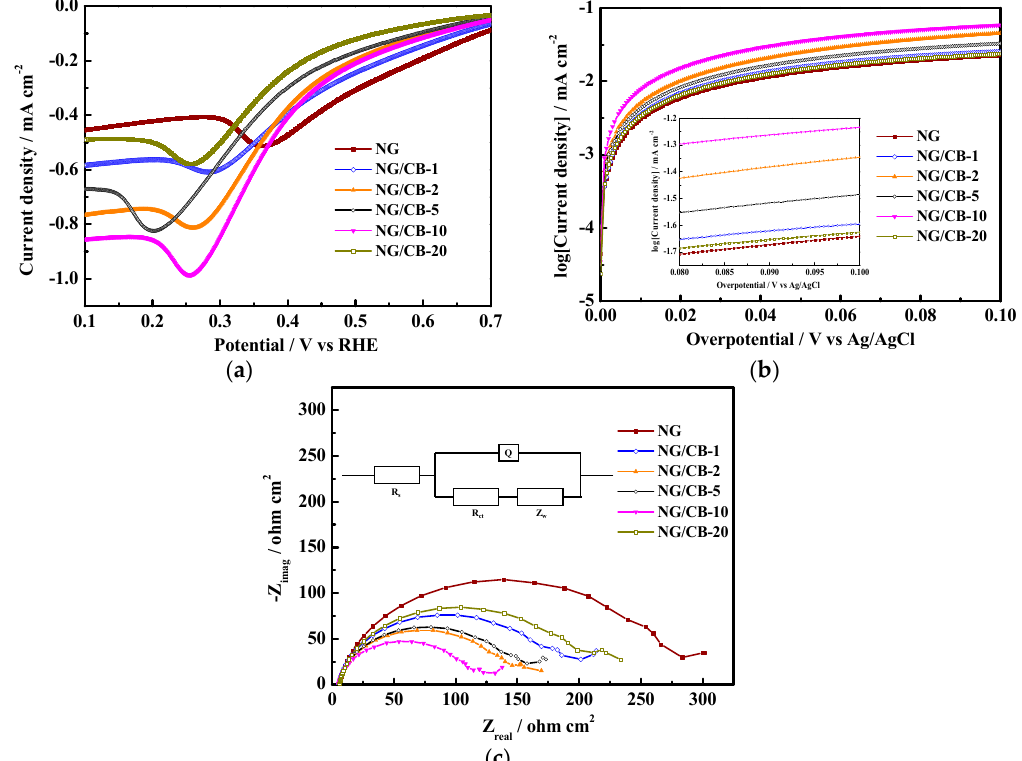
Figure 3. Half-cell tests of NG/CB-x electrocatalysts in O 2 -saturated 0.1 M PBS (electrocatalyst loadings of NG/CB-x were 15 mg cm − 2 ): LSV curves ( a ) Tafel plots (( b ) inset: linear fitting in the overpotential interval of 80 and 100 mV), and EIS tests (( c ) inset: equivalent circuit).